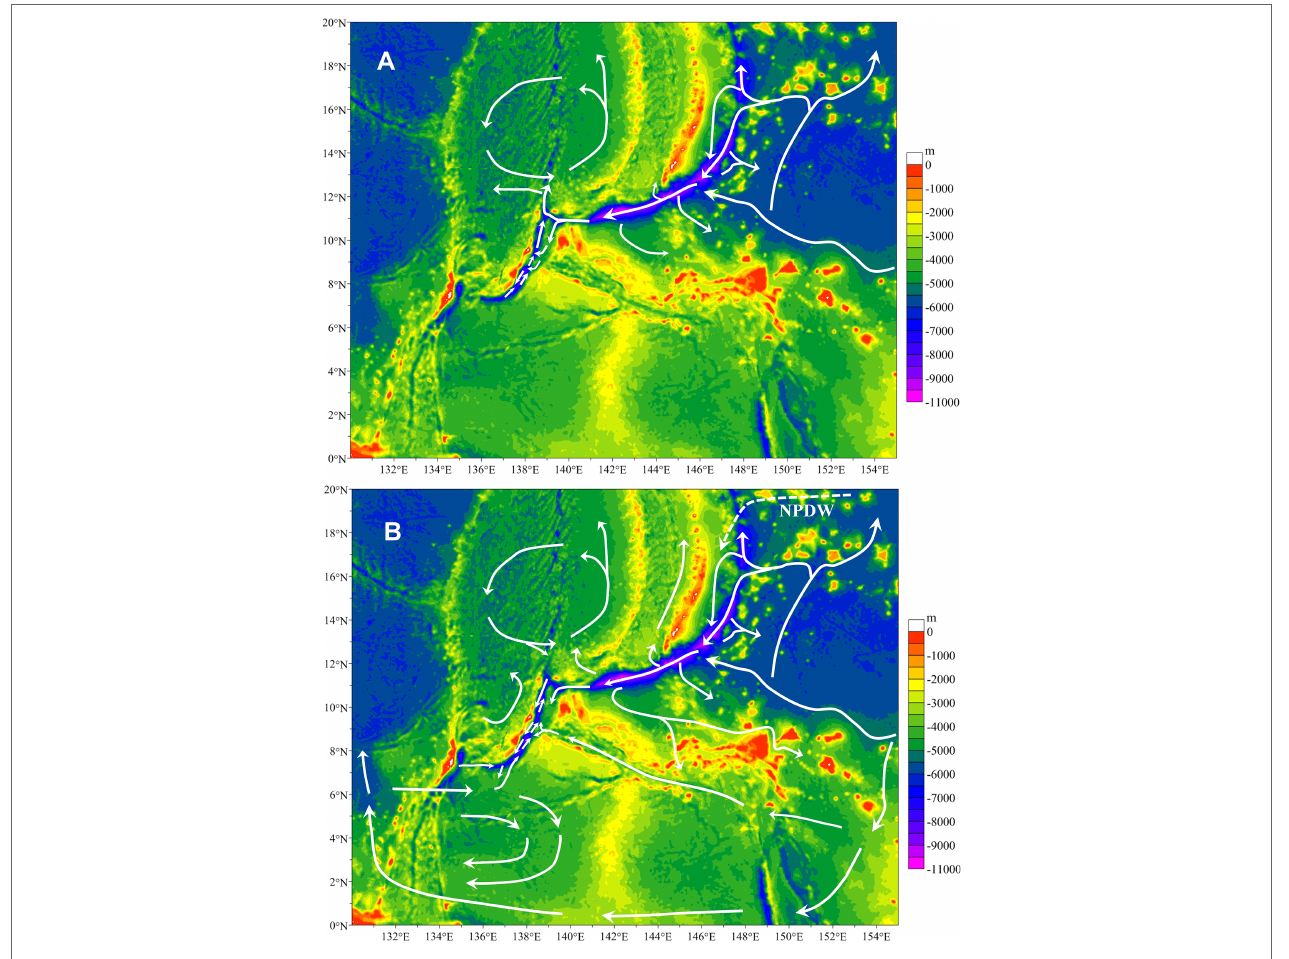
FIGURE 12 | Schematic pathways of abyssal flows in the Yap Trench and adjacent regions: LCPW (A) , and UCPW and NPDW (B)